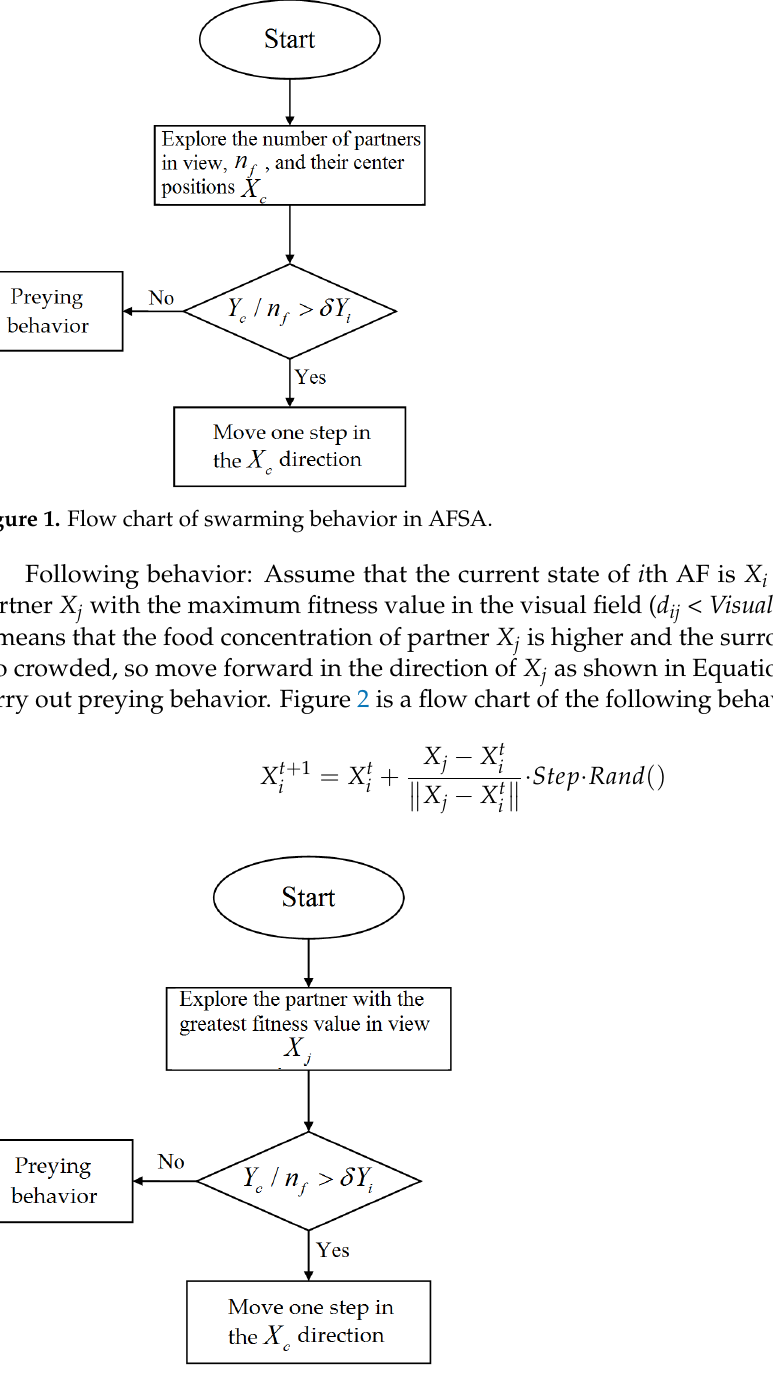
Figure 2. Flow chart of following behavior in AFSA. Random behavior: random behavior is to find a direction randomly in the field of vision and compensate for preying behavior.